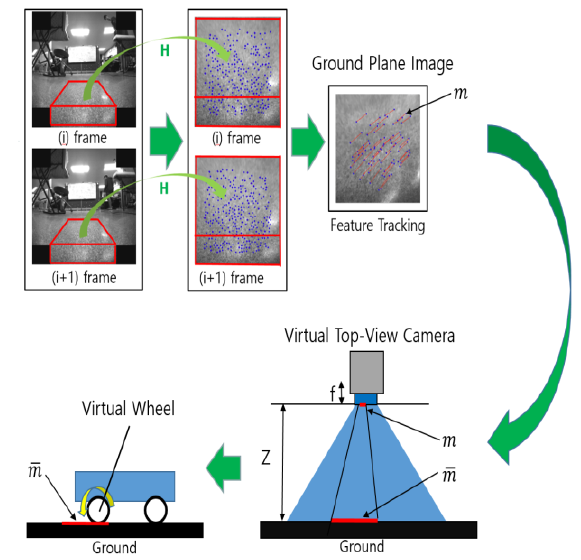
Figure 1 . Belief illustration of our visual odometry system.